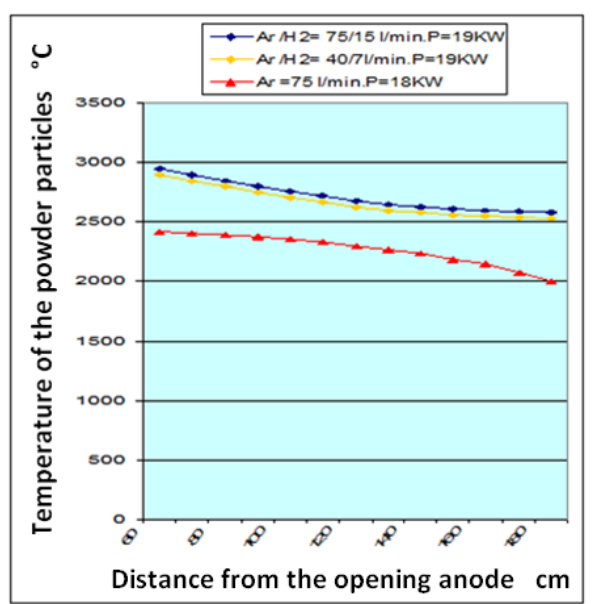
Figure 6 – Effect of H2 on the surface temperature of Al 2 O 3 powder particles Рис . 6 – Воздействие Н 2 на температуру поверхности частиц порошка Al 2 O 3 Слика 6 – Утицај H2 на температуру површине честица праха Al 2 O